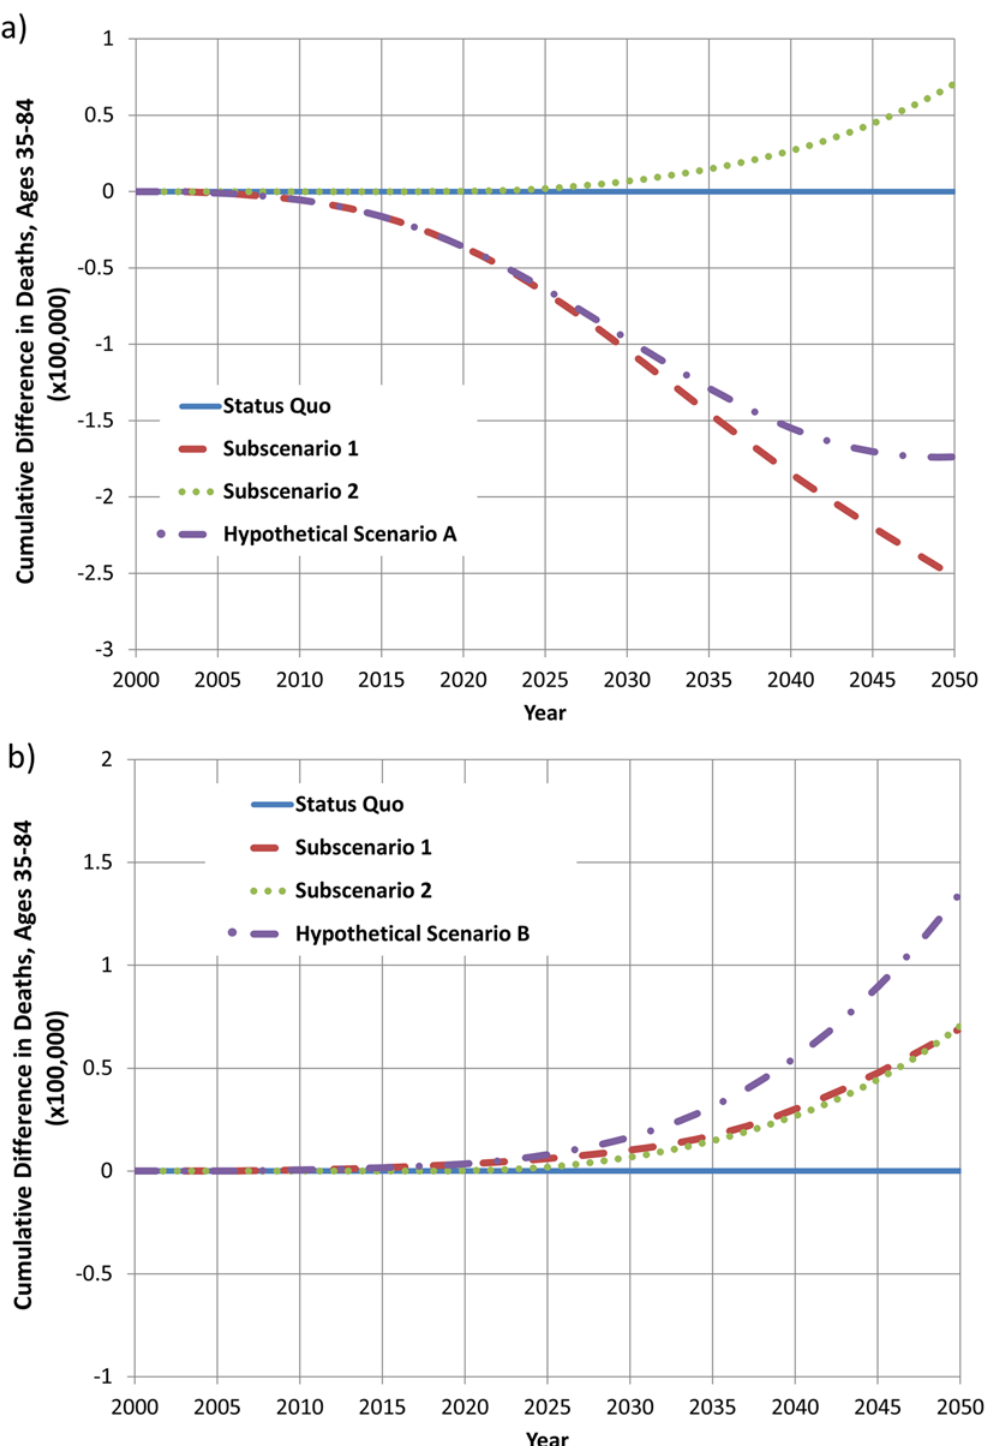
Fig 5. Comparison of cumulative deaths, ages 35 – 84, in status quo and hypothetical scenarios: (a) hypothetical scenario A, in which annual transition rates among smokers are 1.5% for dual use and switching (b) hypothetical scenario B, in which annual transition rates among smokers are 2% for dual use and 1% for